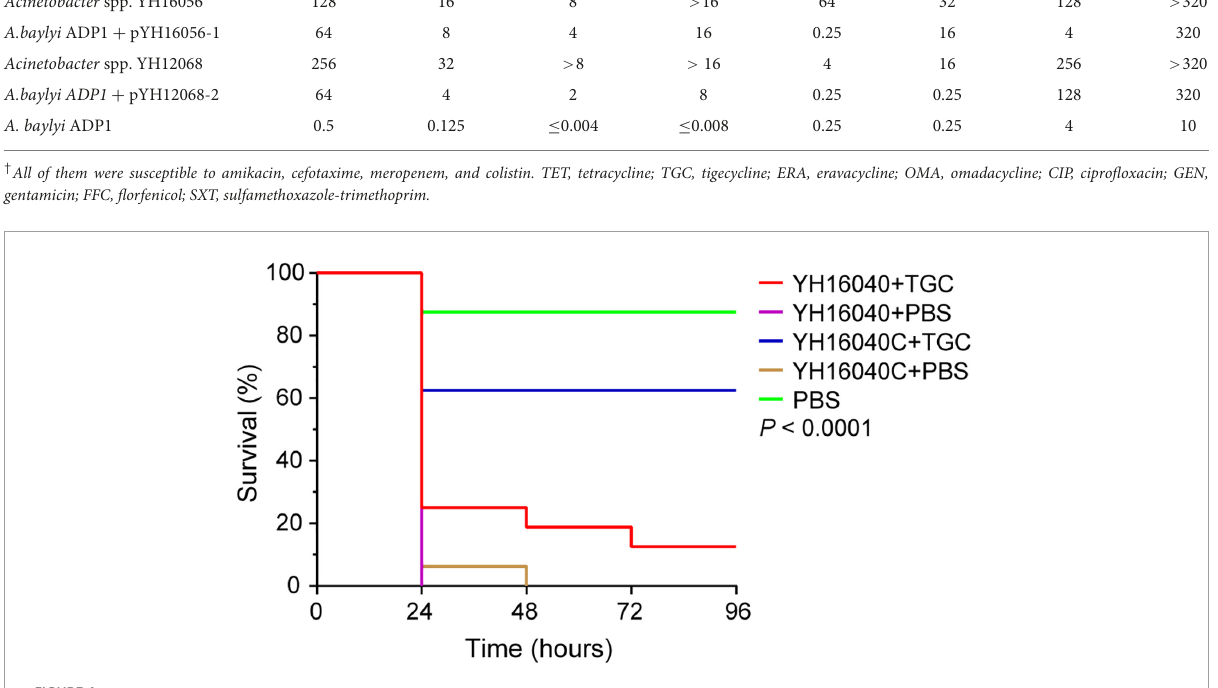
FIGURE4 Survival curve of G. mellonella larvae under the treatment of tigecycline. The P -value is calculated by Log-rank (Mantel-Cox) test between GR31 plasmid-mediated tet (X3)-positive Acinetobacter spp. YH16040 and its plasmid-cured strain YH16040C [ tet (X3)-negative] using GraphPad Prism version